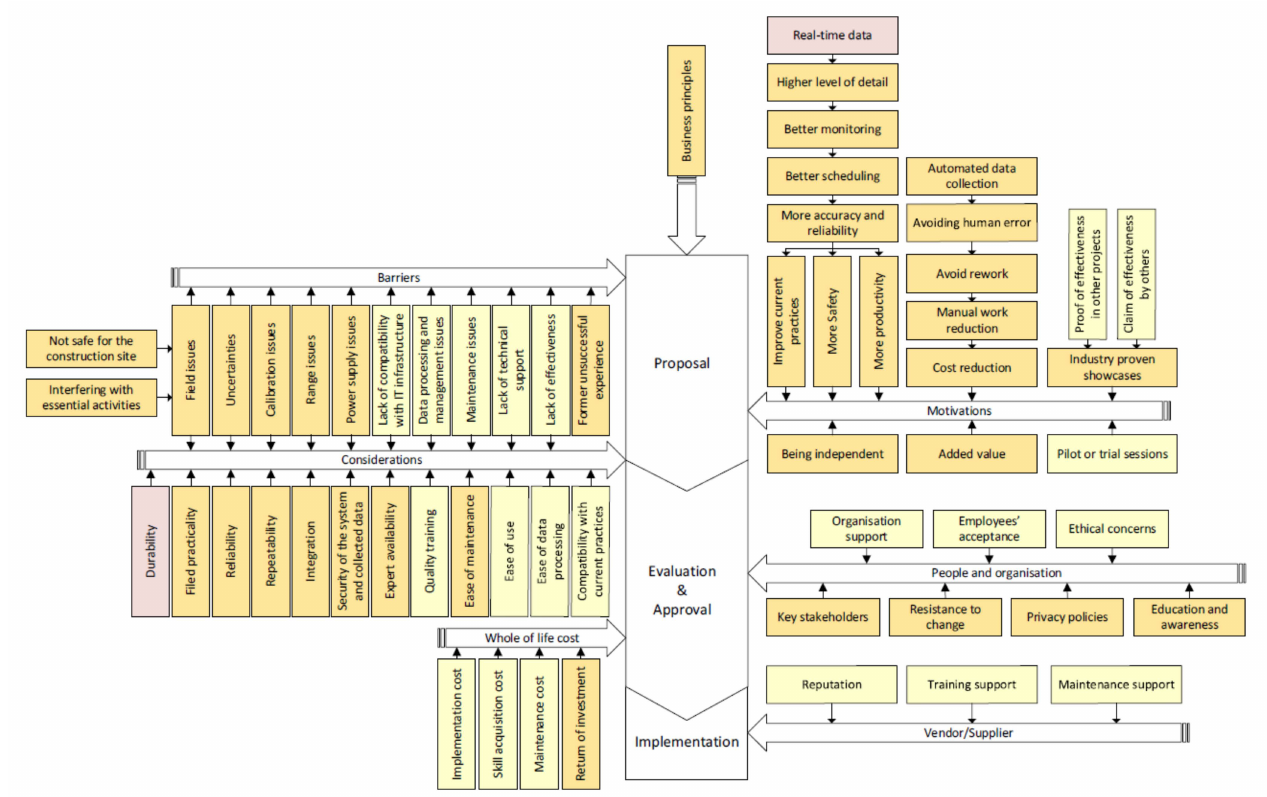
Figure 13. The proposed governance